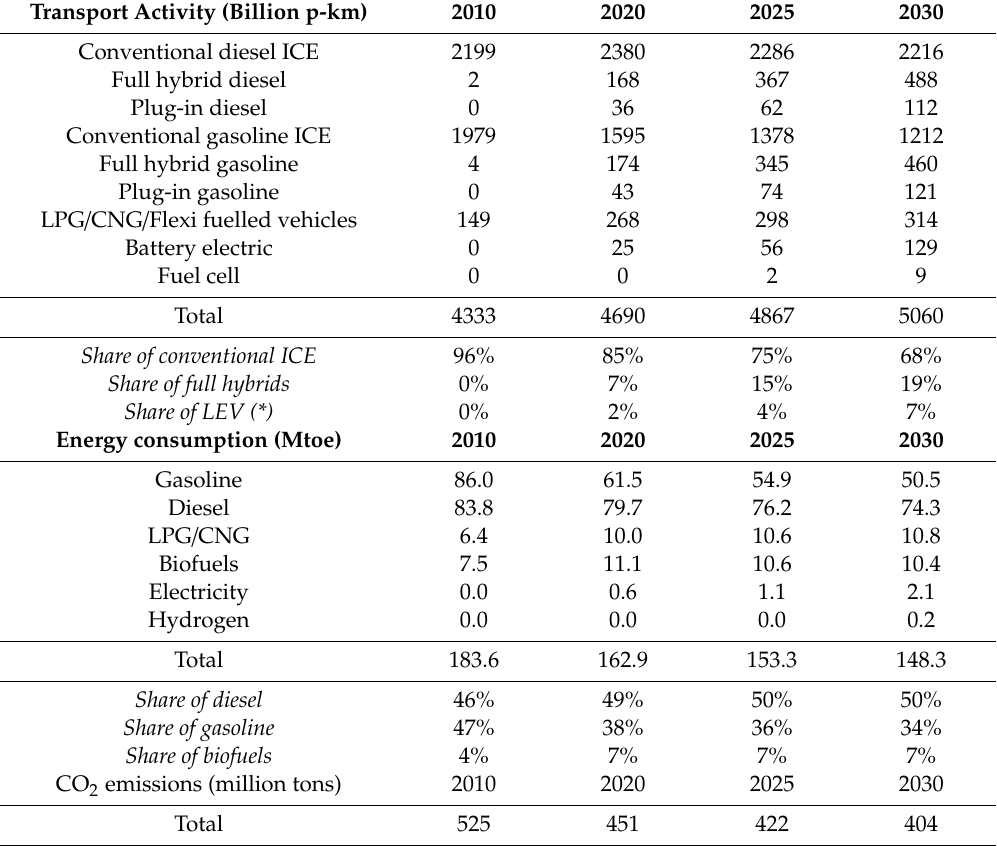
Table 1. Key results of the business-as-usual scenario related to passenger